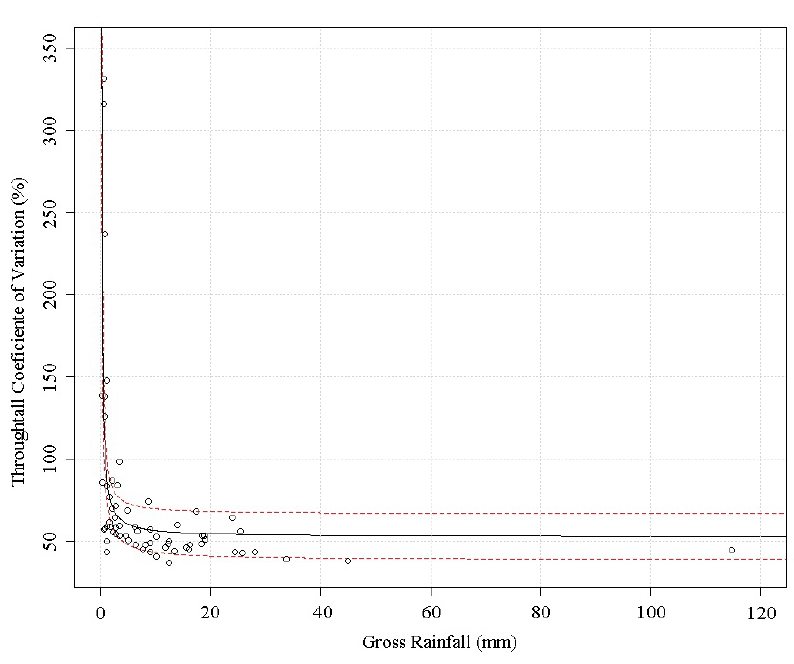
Figure 6. Throughfall coefficient of variance for different rain depth.